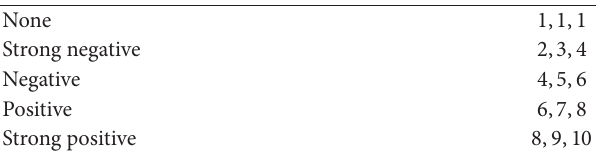
Table 1: Evaluation scale. Table 2: Comparison